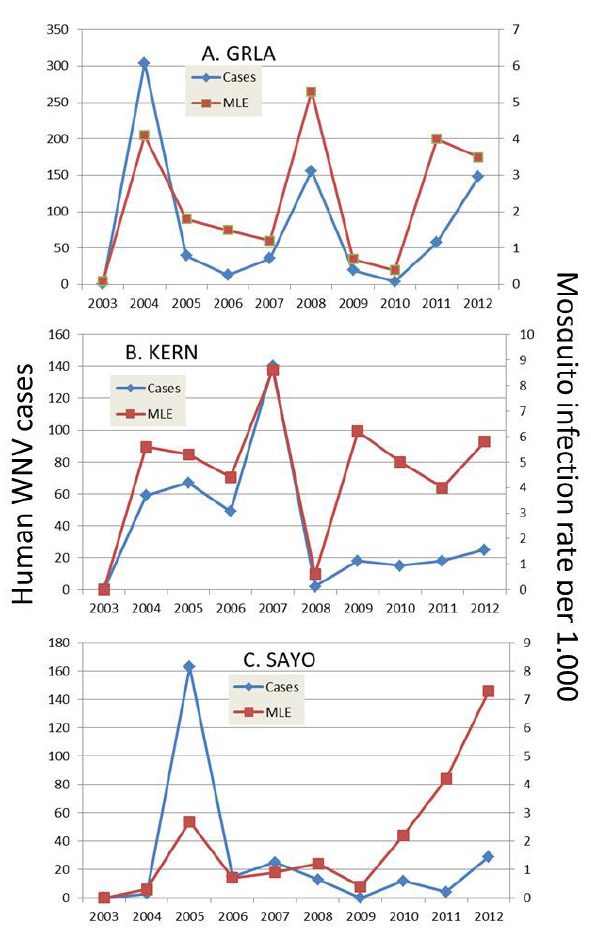
Figure 5. Annual number of human cases and mosquito infection rate per 1000 tested from 2003–2012 for the ( A ) Greater Los Angeles County Vector Control District [GRLA]; ( B ) Kern Mosquito and Vector Control District [KERN] and ( C ) Sacramento-Yolo Mosquito and Vector Control District [SAYO]. Mosquito infection rate was calculated